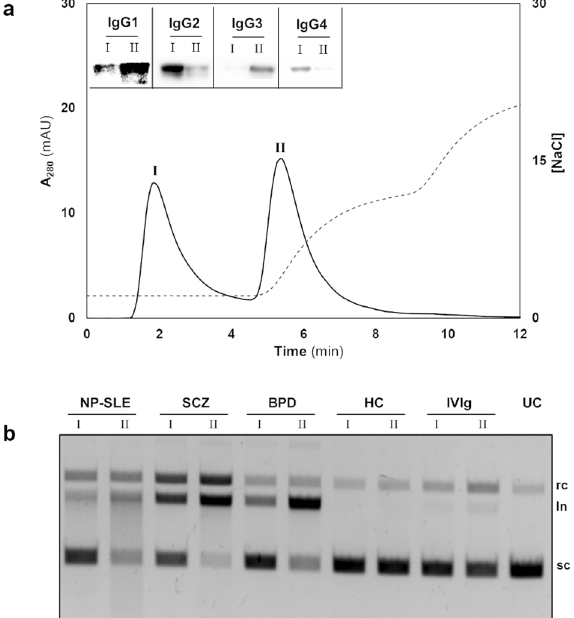
Fig. 6 IgG subclasses separation and DNA hydrolysis. a About 50 µg of pre-puri fi ed total IgG Abs (twofold dilution) suspended in 25 mM Tris-HCl pH 7.4 was fractionated and eluted using 25 mM Tris- HCl pH 7.4 + 0.2 M NaCl. Peak I- fl ow-through, Peak II-elution. Inset: IgG subclasses in the peak I and II were discriminated by separate western blots. b DNA hydrolysis exhibited by peaks I (lane I) and II (lane II). UC- scDNA incubated alone; sc supercoiled DNA, rc relaxed circular DNA, ln linear